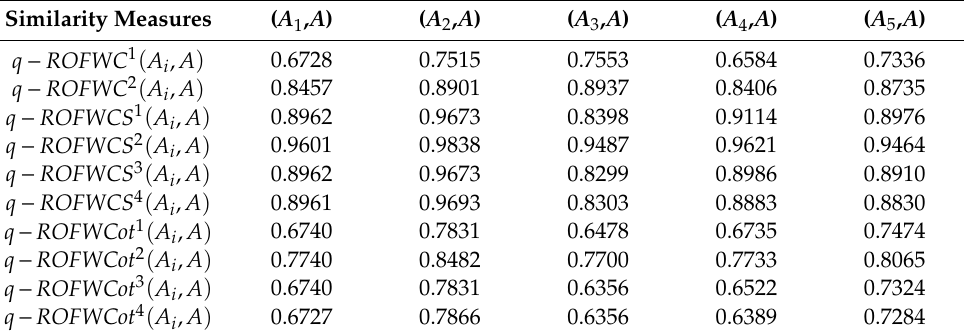
Table 2. The weighted similarity measures between A i ( i = 1,2,3,4,5 ) and A .